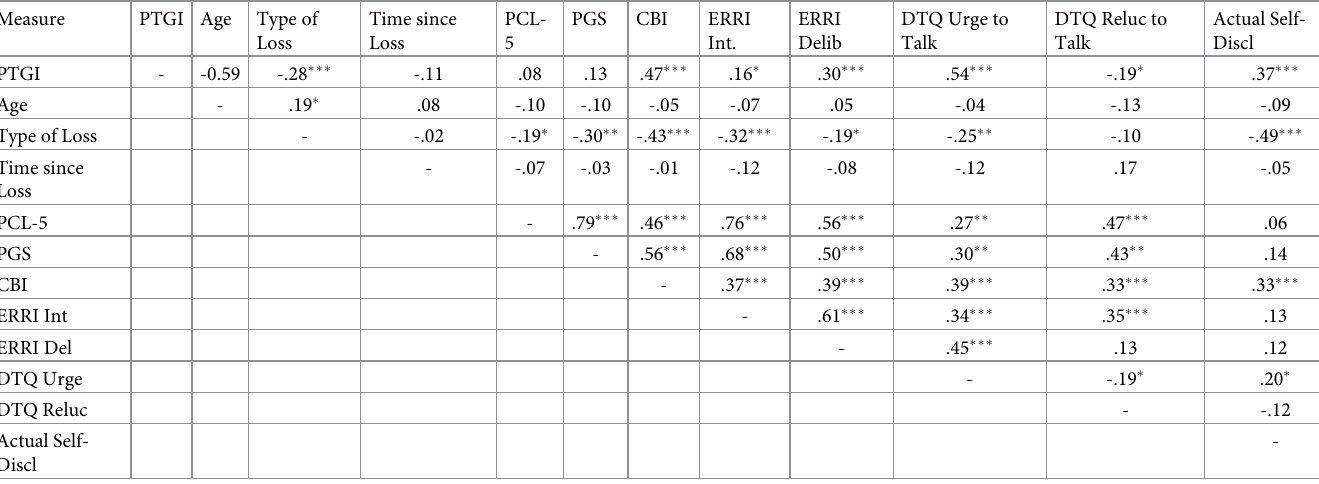
Table 3. Bivariate correlations for both stillbirth and early miscarriage groups.